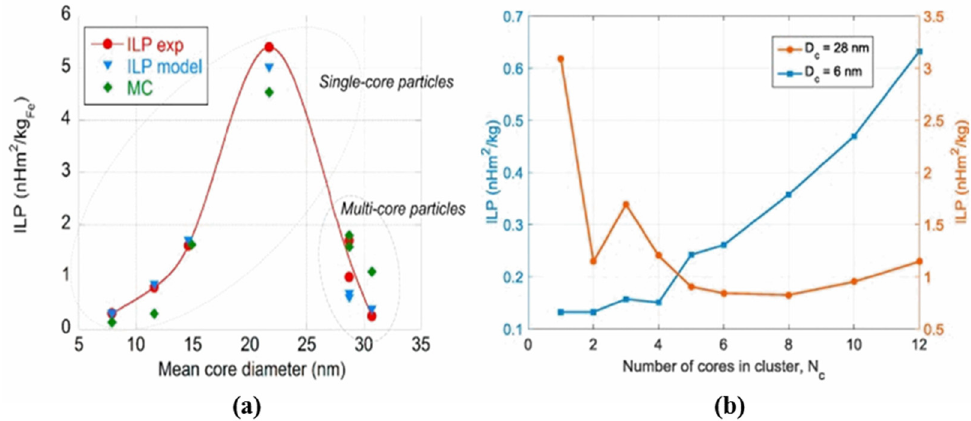
Figure 12. ( a ) Experimental (red) and simulated ILP data analysis for noninteracting (blue) and interacting single-core particles (green); ( b ) Simulated ILP versus the number of cores in a core cluster for two core sizes, below (6 nm) and above (28 nm) the core size maximizing the ILP value. Reprinted with permission [119]. Copyright 2021, Elsevier.